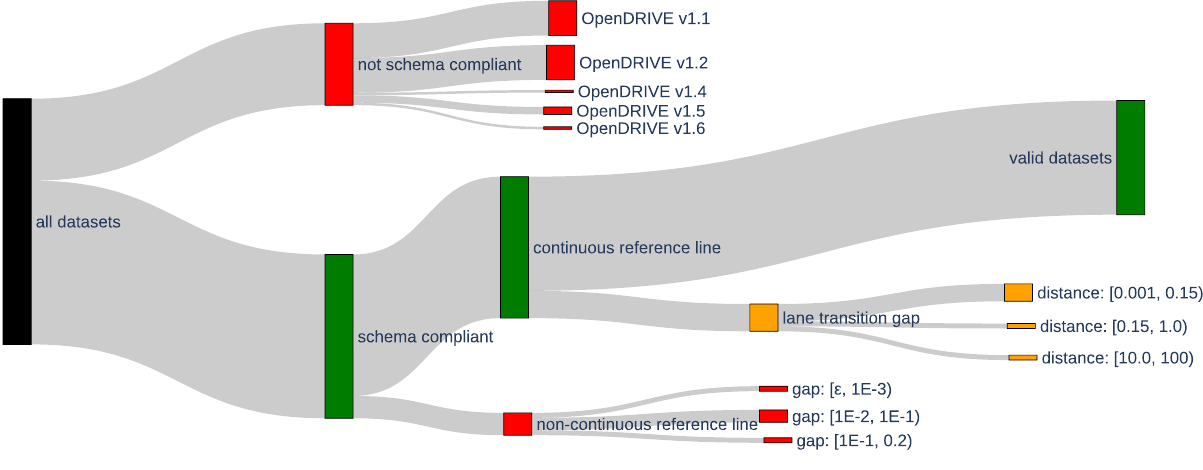
Figure 19. Overview of the tested OpenDRIVE datasets and at which validation step they fail. Green means (still) valid, red indicates not valid and orange denotes valid but not recommended according to the